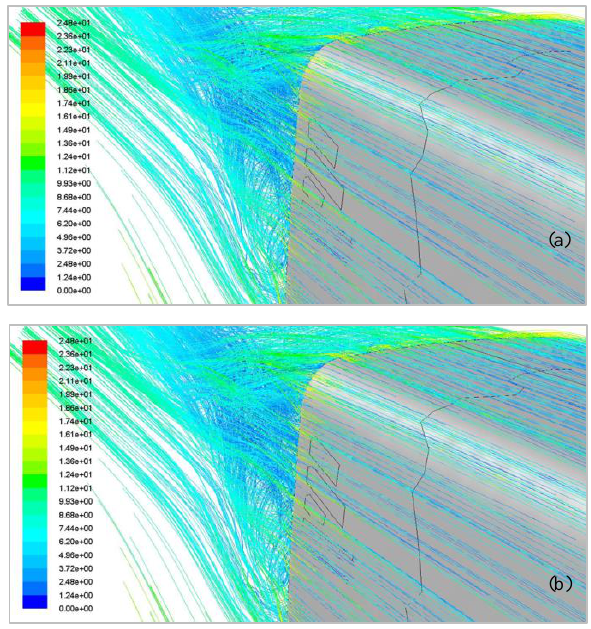
Fig. 7. Streamlines based on velocity [m/s] – radiator inlet grilles and streamlines with operating fans: view of the inlet grilles: a) when